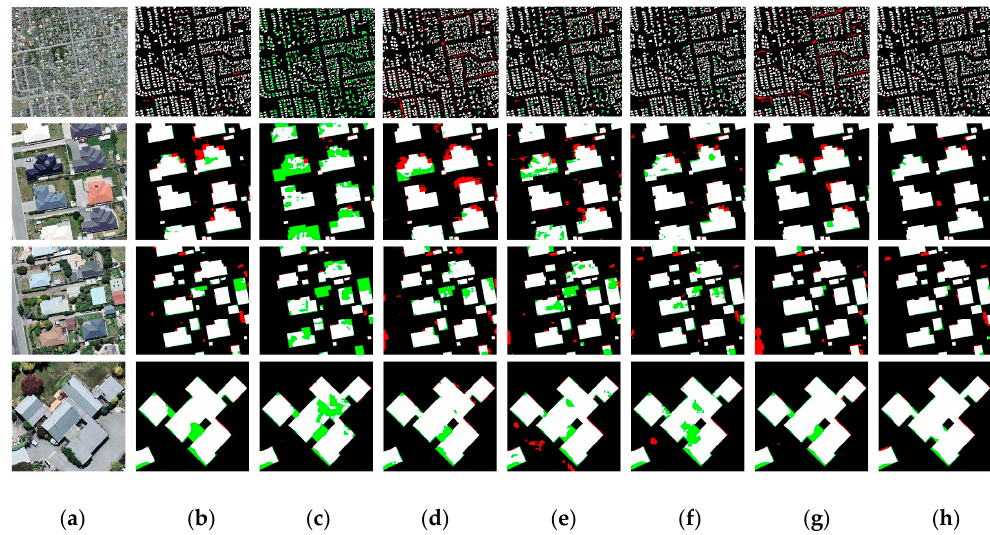
Figure 7. Visual comparison of segmentation results by seven approaches (for an urban area of Waimakariri, New Zealand). The first row shows the overall results, and the last three rows exhibit the zoomed-in results. In the colored figures, the white, red and green colors represent true positive, false positive and false negative predictions, respectively. ( a ) Image. ( b ) FCN-8s. ( c ) SegNet. ( d ) DeconvNet. Table 5. Quantitative comparison of five conventionally used metrics (for an urban area of Waimakariri, New Zealand) obtained from the segmentation results by FCN-8s, SegNet, DeconvNet, U-Net, ResUNet, DeepUNet and the proposed DeepResUnet, where the values in bold format are the highest numbers for corresponding metrics.